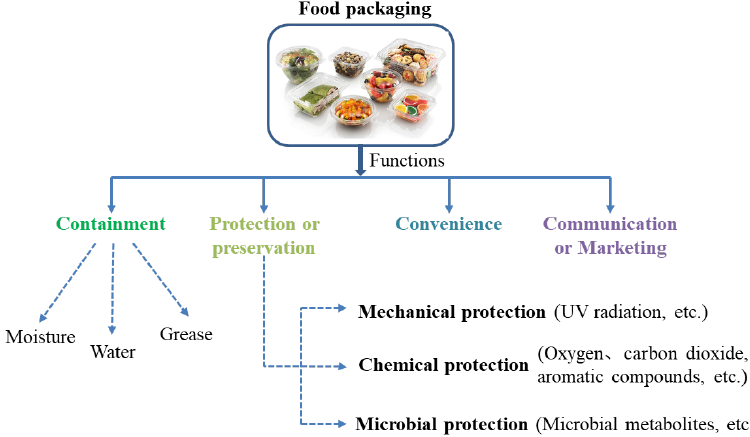
Figure 1. The functions and properties of packaging system.